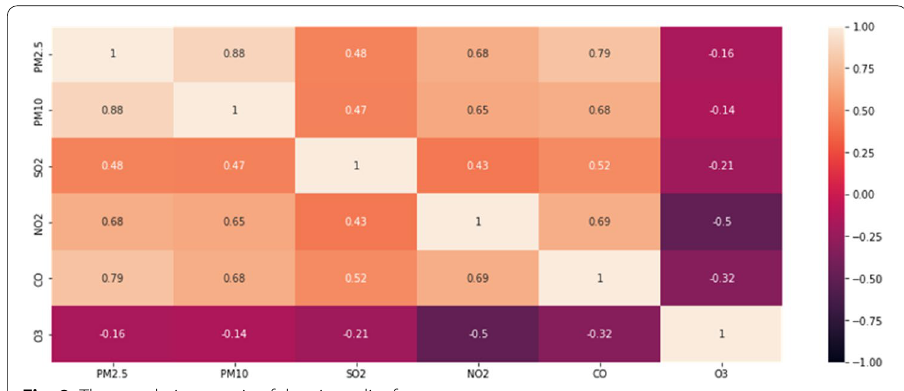
Fig. 8 The correlation matrix of the air quality features